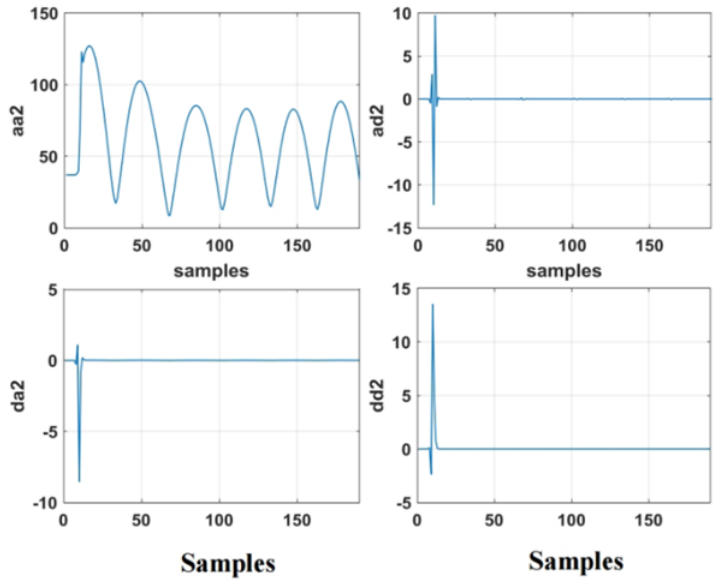
Figure 15. The 2nd level WPT-coefficients for faulty condition.